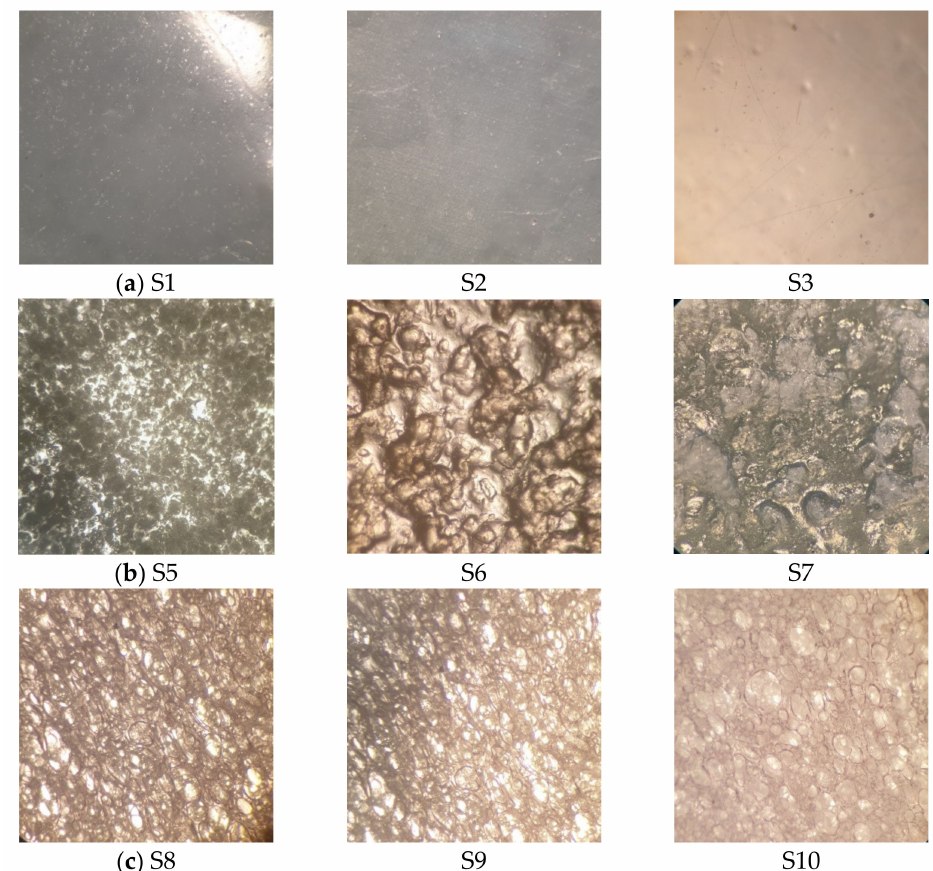
Figure 1. Photomicrographs (50 × ) of the investigated printing substrates obtained by trinocular microscope: ( a ) subset I; ( b ) subset II and ( c ) subset III (for the sample composition refer to Table